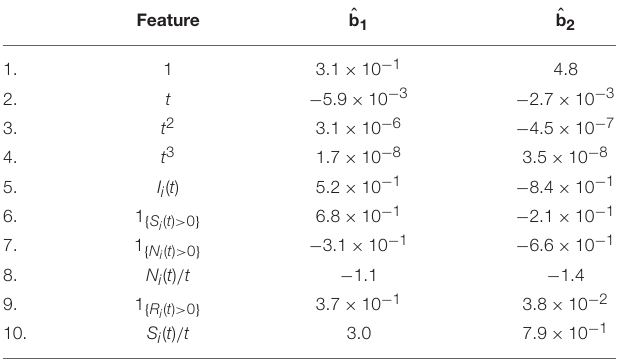
TABLE 4 | Estimated regression coefficients for a model for which the event history process contains the initial features based on polynomials of t and the top six features selected by cross